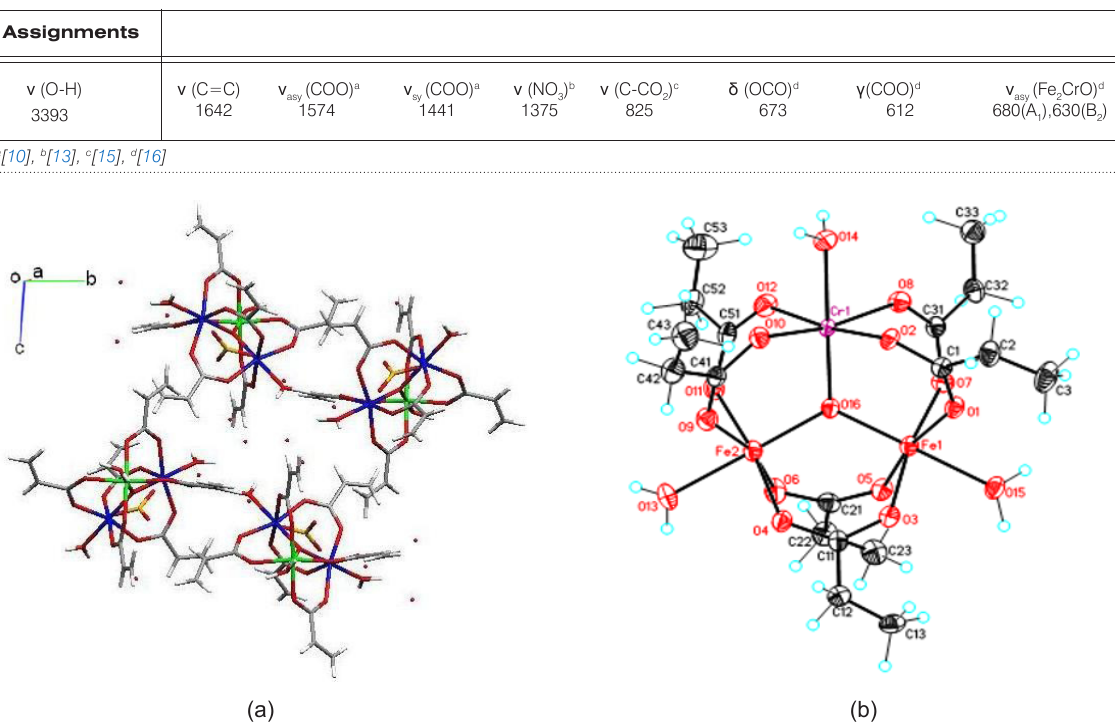
Cr(µ -O) (C H O ) (H O) ] •NO •4H O ( 1 ) (a) and the 2 3 3 3 2 6 2 3 3 2